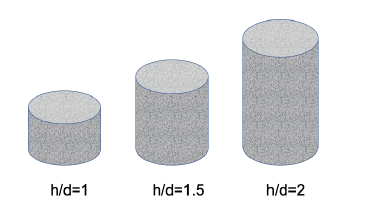
Figure 1. Geometry of the specimen under considerations.